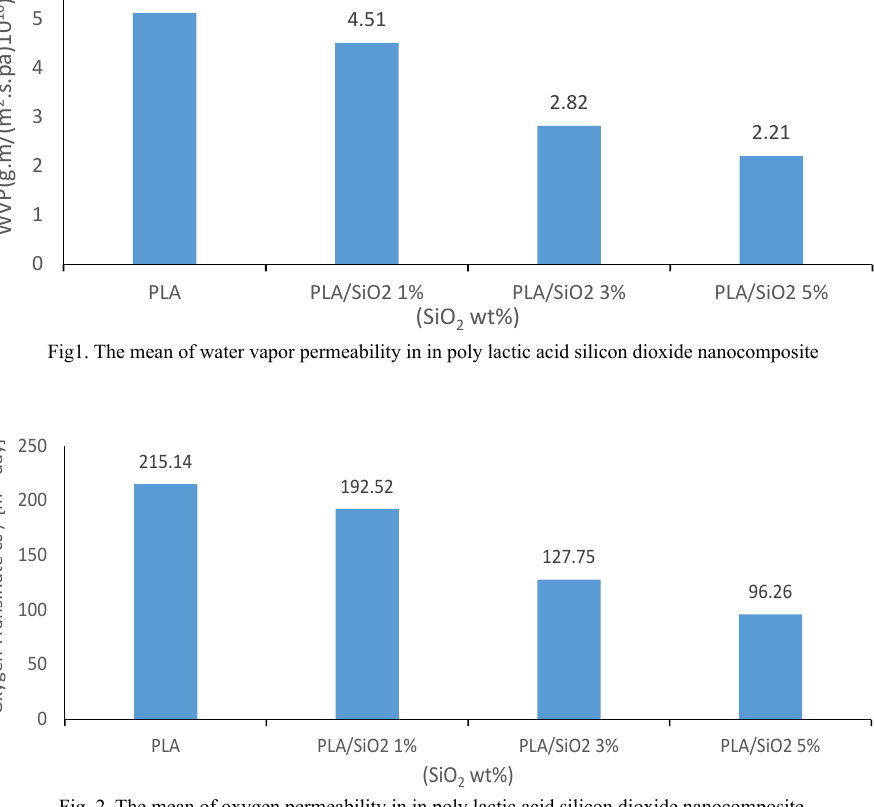
Fig. 2. The mean of oxygen permeability in in poly lactic acid silicon dioxide Fig2. The mean of oxygen permeability in in poly lactic acid silicon dioxide nanocomposite